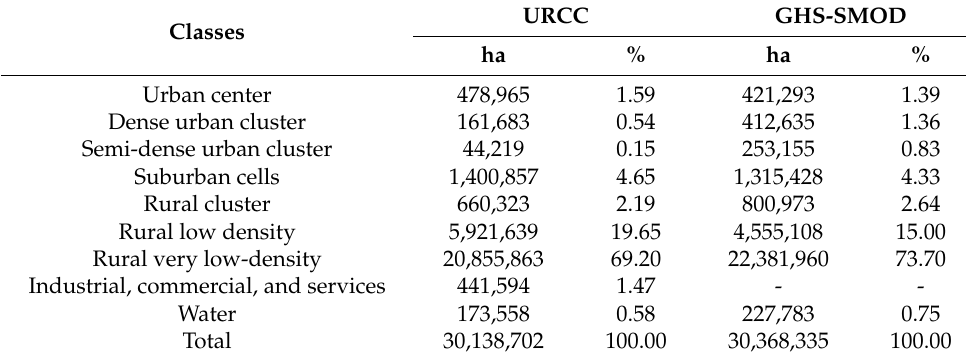
Table 4. Extension of the urban–rural continuum classes on the national territory, expressed in hectares and percentage and compared with the GHS-SMOD data.